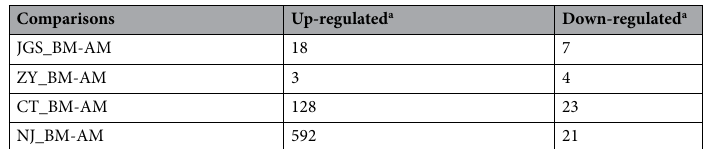
Table 5. The number of DEGs up-regulated and down-regulated before mating (BM) relative to after mating and oviposition (AM). a Numbers refer to the quantity of up- or down-regulated DEGs in the before-mating (BM) sample relative to the after-mating/oviposition (AM) sample of each pairwise comparison.